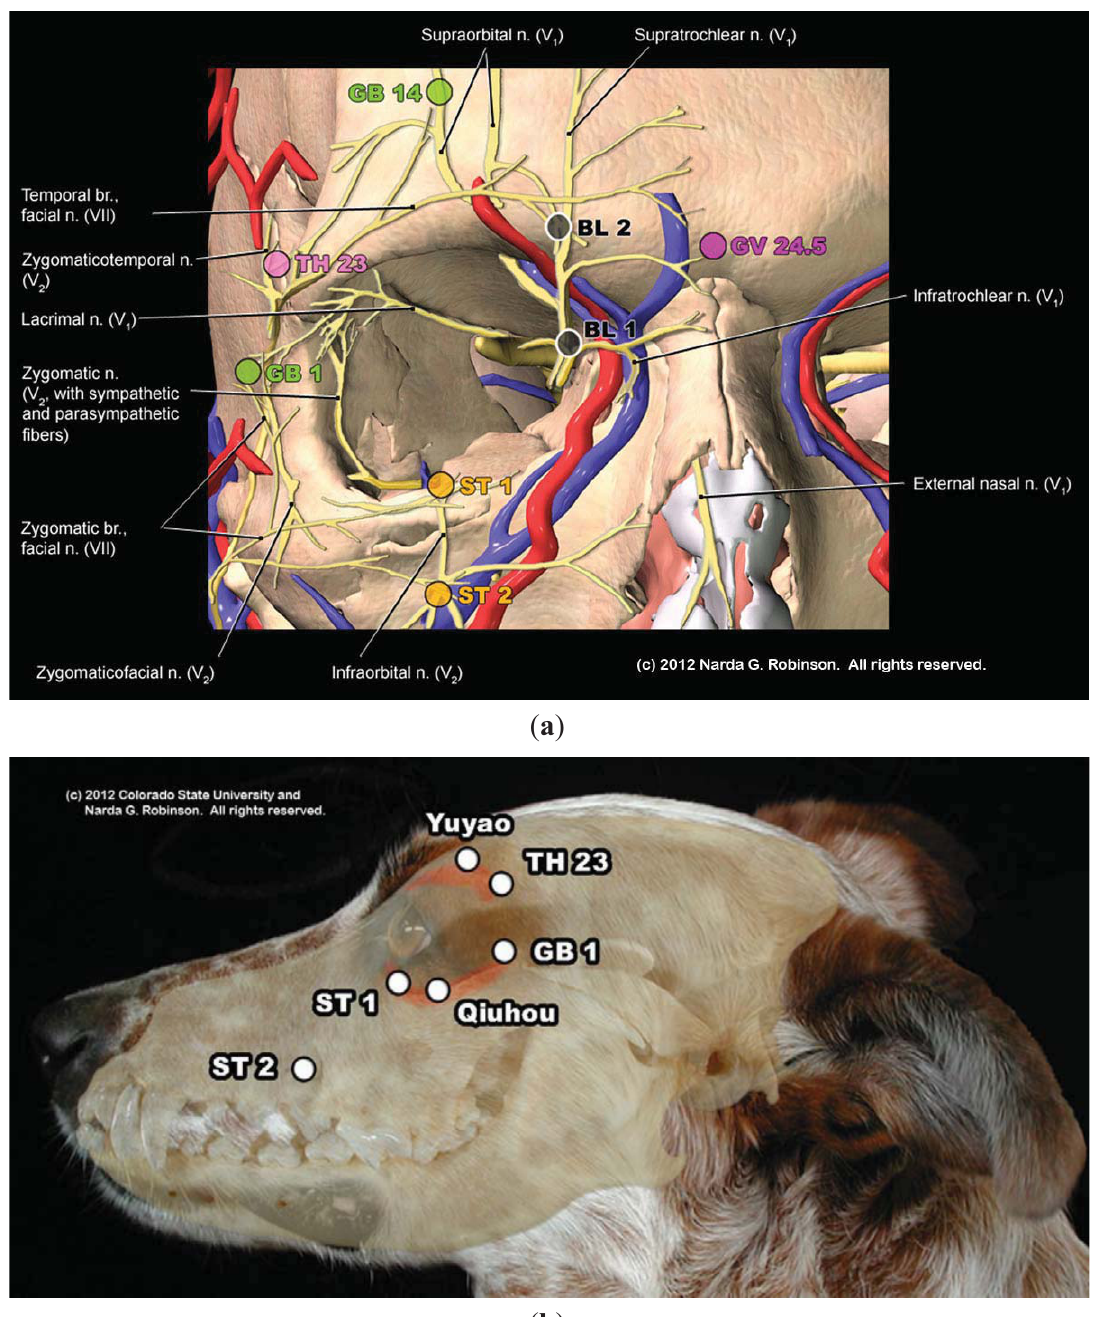
Figure 1. ( a ) This image illustrates the complete bony orbit of the human. Note the relationship of periocular acupuncture points to the orbit, showing how a needle inserted into TH 23 would reach bone and deliver feedback through the needle and to the acupuncturist that a hard surface was reached. In addition, this rendition reveals the complex interplay of trigeminal and facial nerve branches that mediate the ophthalmic benefits of needling TH 23. (Image courtesy of Narda G. Robinson, DO, DVM, MS and Teton NewMedia. From [17]); ( b ) This overlay image of the dog reveals the relationship of the skull to a dog’s external features. Note the hiatus of the orbit between GB 1 and the site just ventral to TH 23. (Image courtesy of Narda G. Robinson, DO, DVM, MS and Colorado State